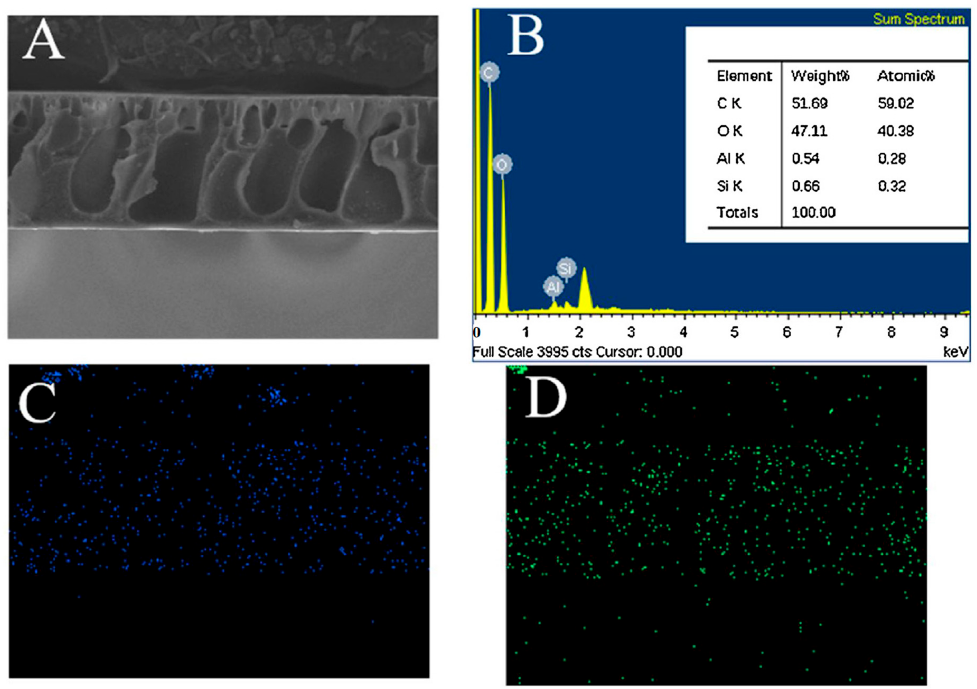
Figure 5. ( A ) SEM micrograph of the cross-section of 3 wt.% LPDHNTs/CA composite membrane, ( B ) the corresponding energy-dispersive X-ray spectroscopy (EDS) spectrum, ( C , D ) EDS mapping of Si and Al elements respectively. Reproduced with permission from Ref. [129]. Copyright 2017